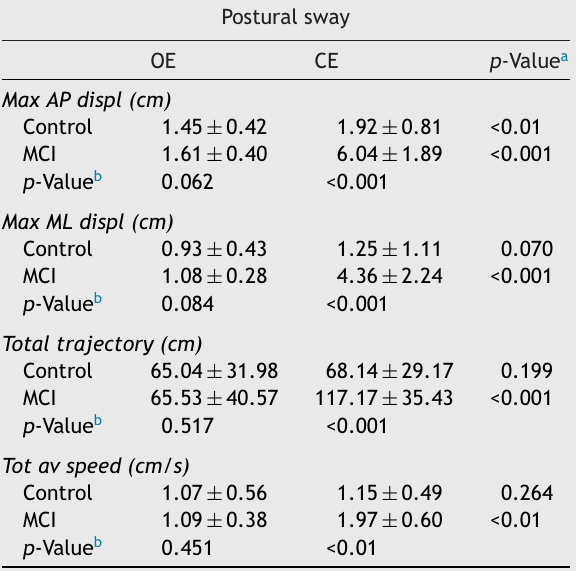
Parameters of body sway of the two study groups